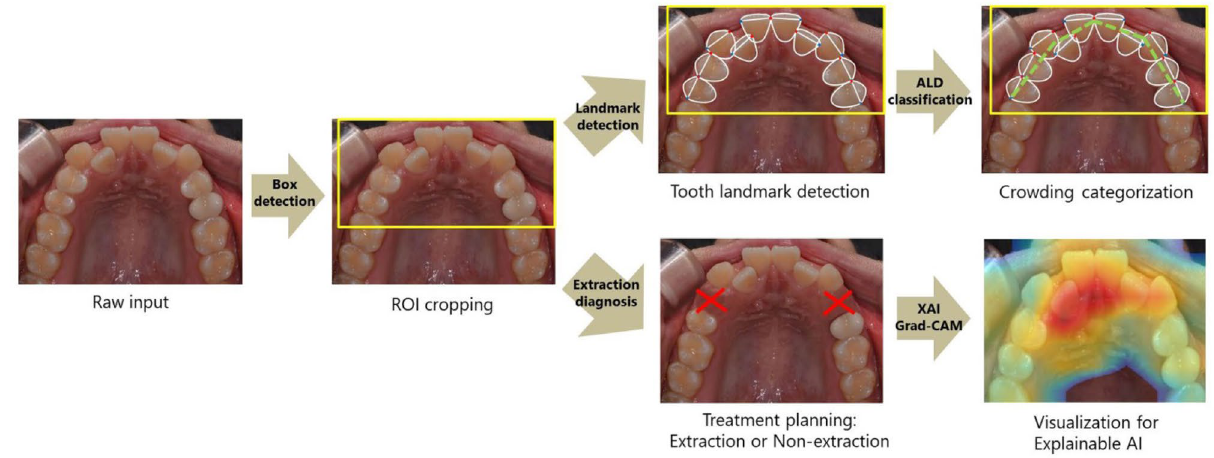
Figure 1. Overall flow diagram of the processes: the input photographs initially undergo ROI cropping and are then fed into the models for landmark detection, crowding categorization, and tooth extraction